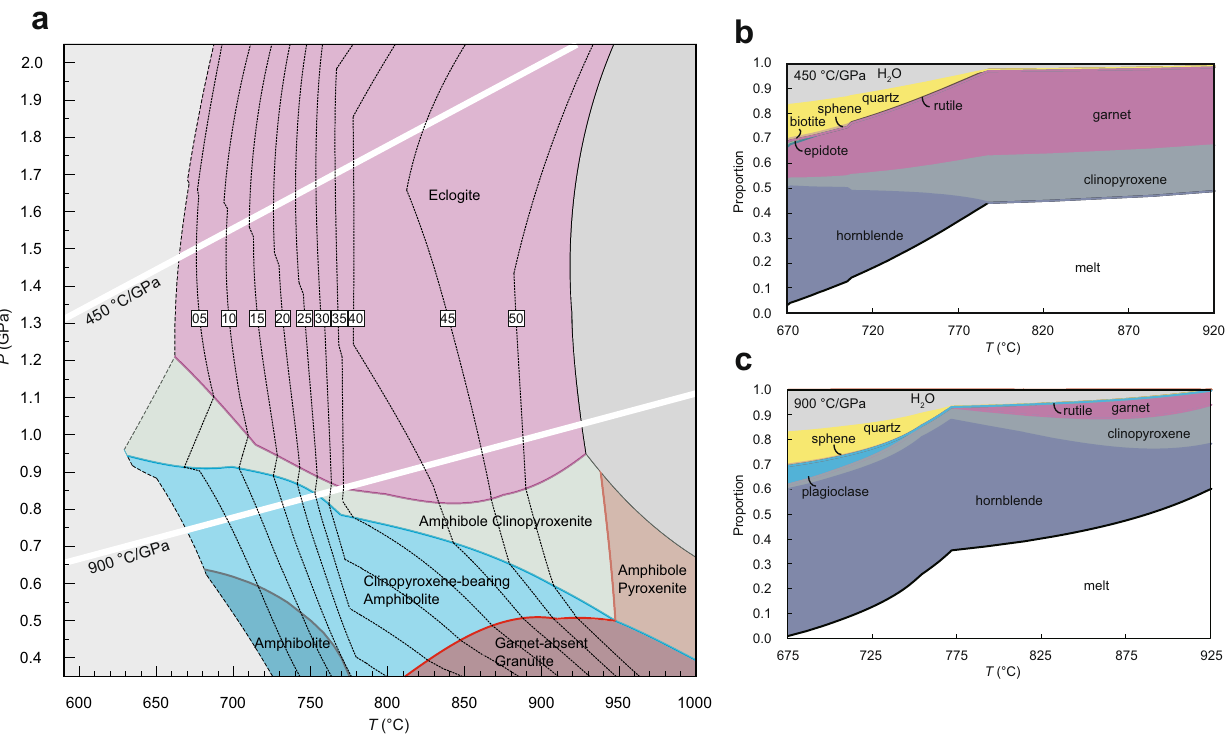
Fig. 2 | Phasediagrams for anaverageArchaeantholeiitic basalt.a Asimpli fi ed pressure – temperature ( P – T ) diagram of an average Archaean tholeiitic basalt